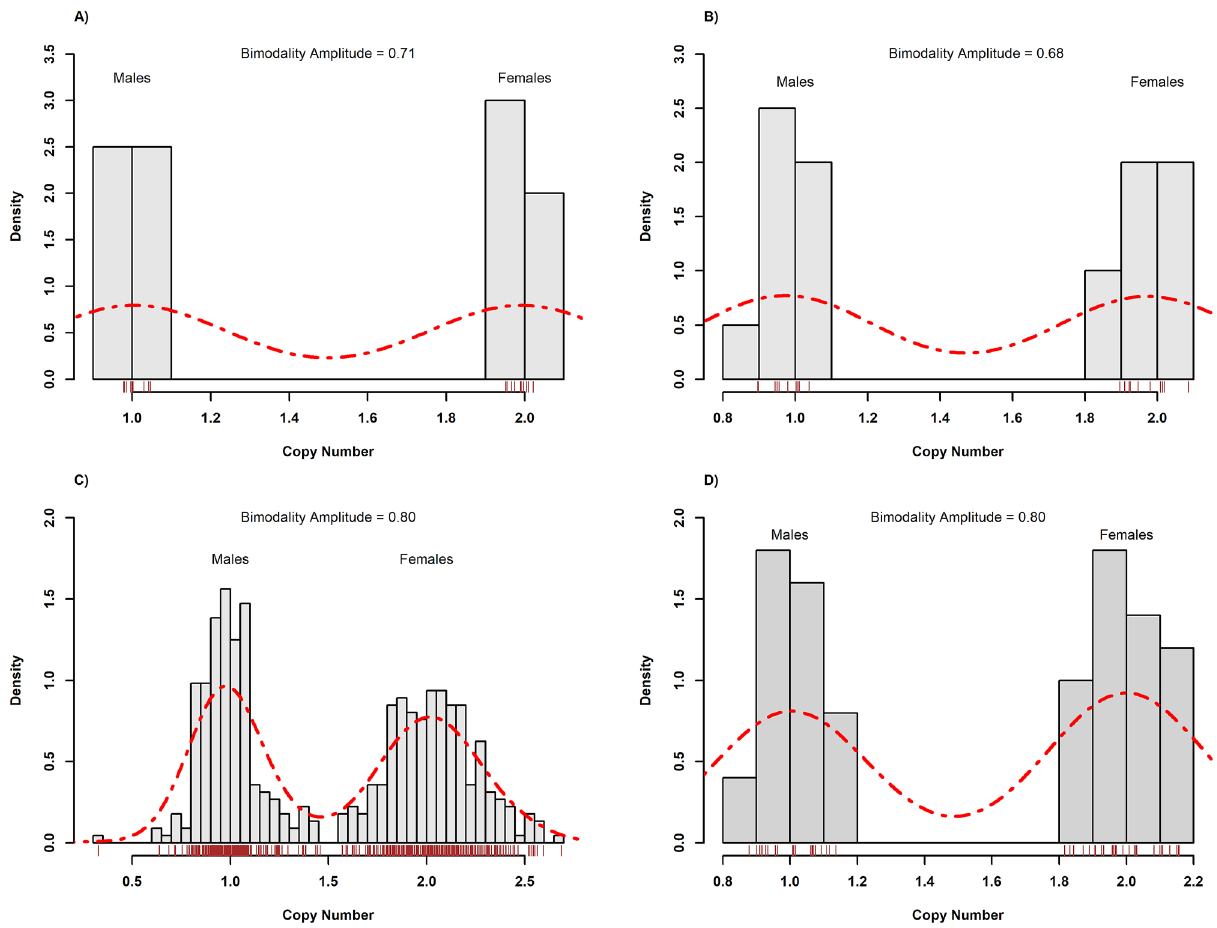
Figure 2. Bimodal distribution of copy number values (CNV) documents the ability of ddPCR and qPCR to distinguish females and males in: the collection A using ddPCR ( A ) and qPCR ( B ), the collection B using qPCR ( C ), and the collection C by qPCR ( D ).